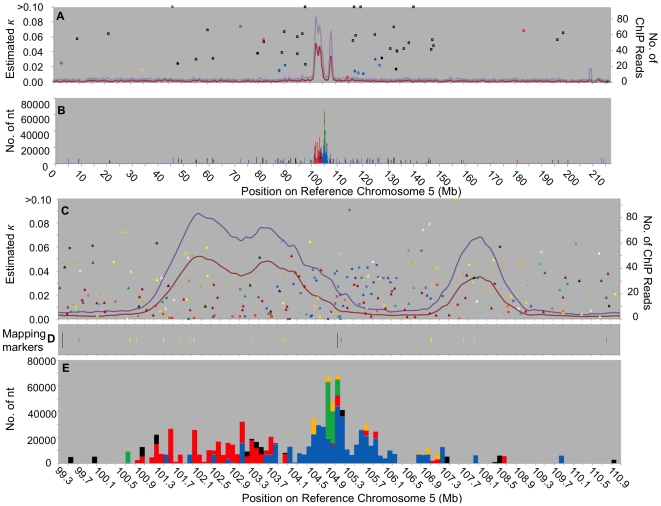
Fine-scale physical maps of centromere 5.Panels and legend as in Figure 2. Elements with κ>0.1 include: (A,B) a CRM1 at 45,864,292 (κ = 0.125), CRM4s at 96,757,409 (κ = 0.101), 115,640,763 (κ = 0.14), 118,276,888 (κ = 0.18), and 138,633,510 (κ = 0.172), (C,D) cinful at 107,583,697 (κ = 0.11) and 107,592,411 (κ = 0.11).